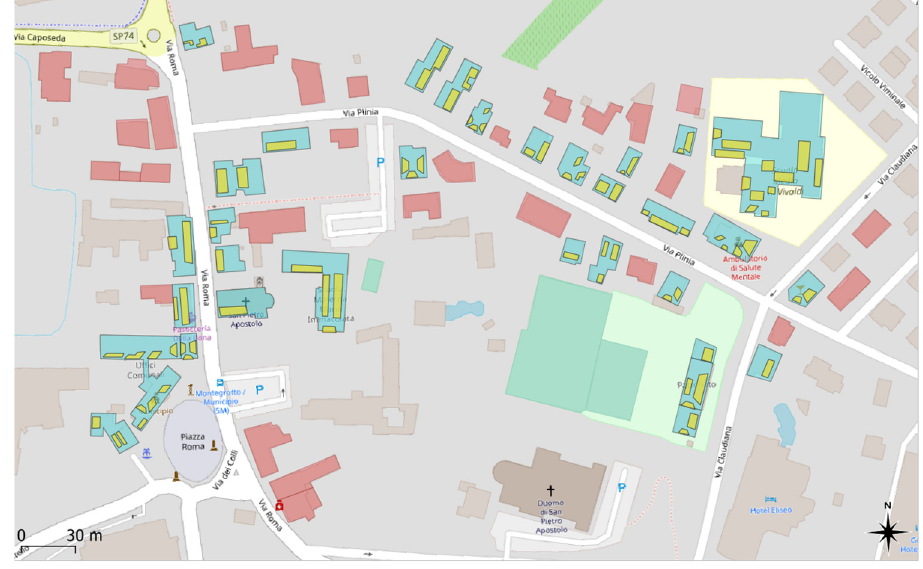
Figure 1. Map of the area analysed in Montegrotto Terme [20].